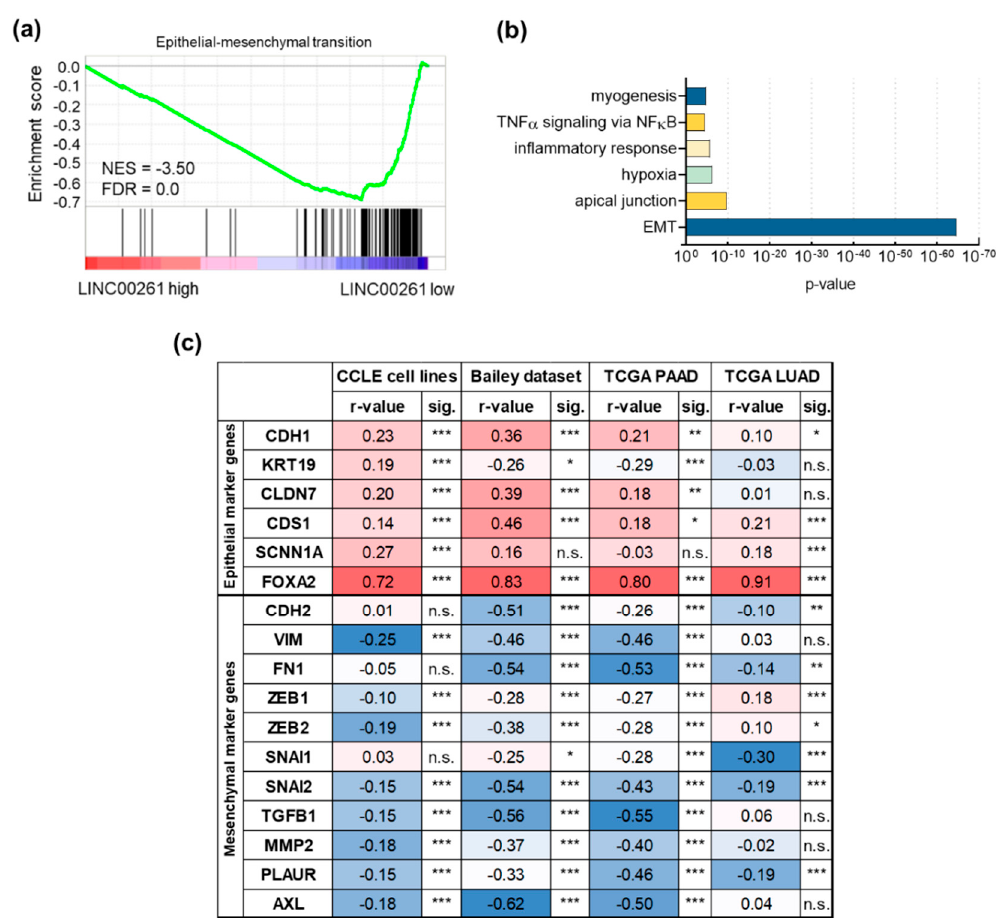
Figure 2. Association of long intergenic non-coding RNA 261 (LINC00261) with epithelial–mesenchymal transition (EMT). ( a ) Gene set enrichment analysis (GSEA) of PDAC samples with low ( n = 48) versus high LINC00261 expression ( n = 48). Median LINC00261 expression was used as a cut- off; NES, normalized enrichment score; FDR, false discovery rate. ( b ) GSEA analysis of genes that were significantly inversely correlated with LINC00261 in the pancreatic adenocarcinoma (PDAC)